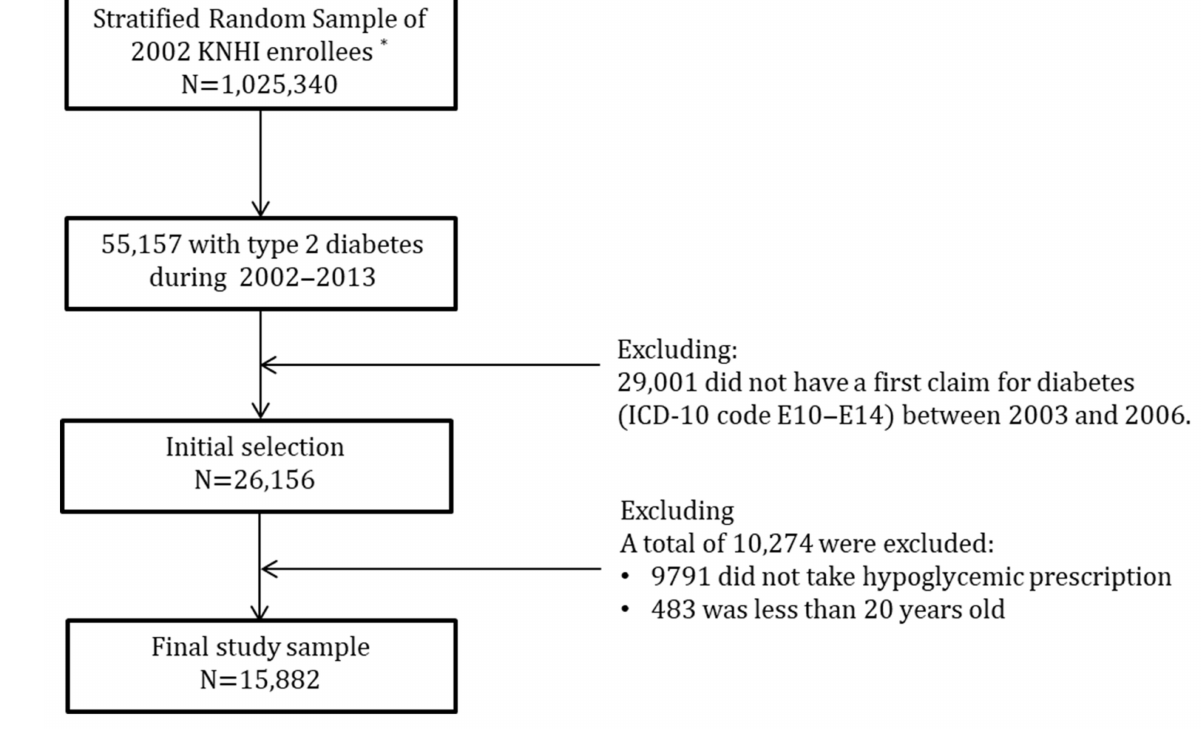
Figure 1. Flowchart for sample selection. *, the Korean National Health Insurance, this is an universal health insurance plan that covers almost all the population and medical